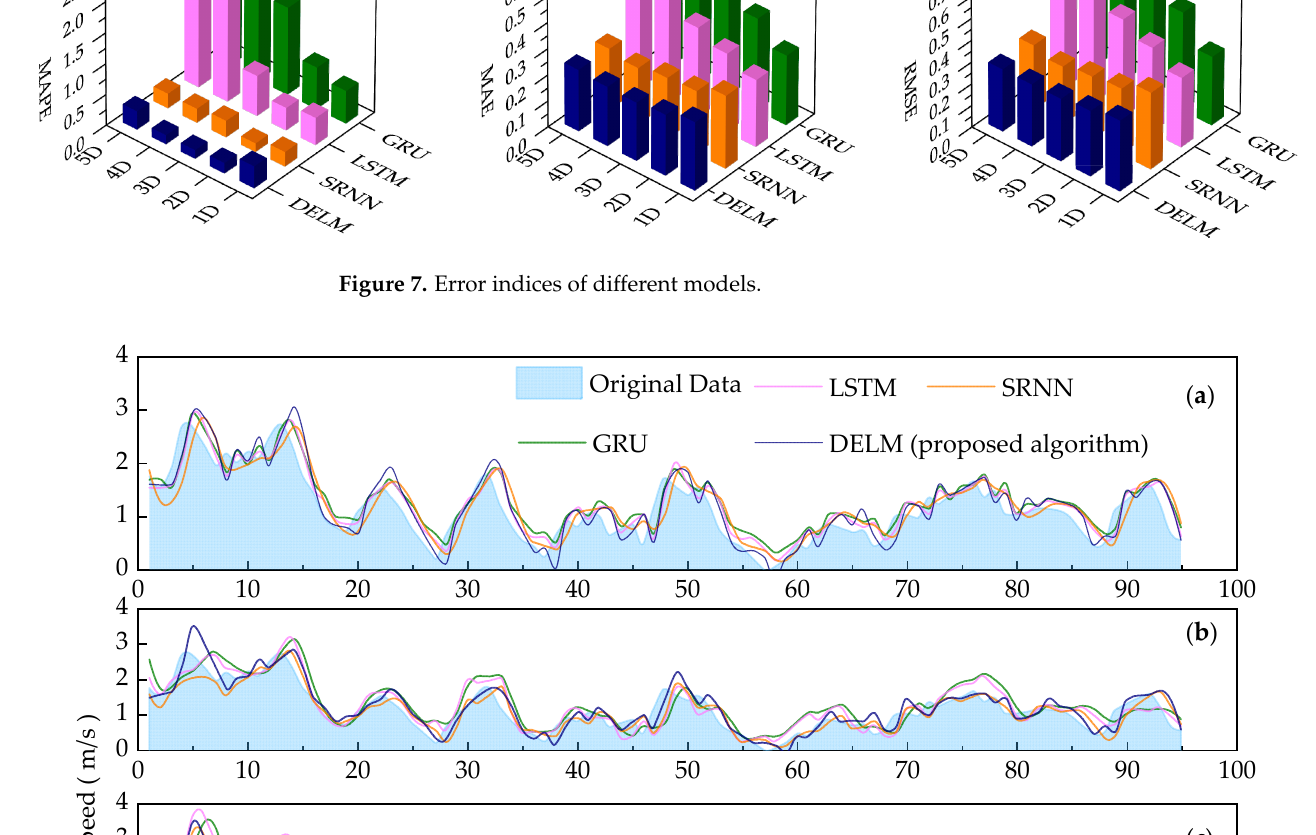
Table 3. CPU time for both training and testing sets of different models (s) *.